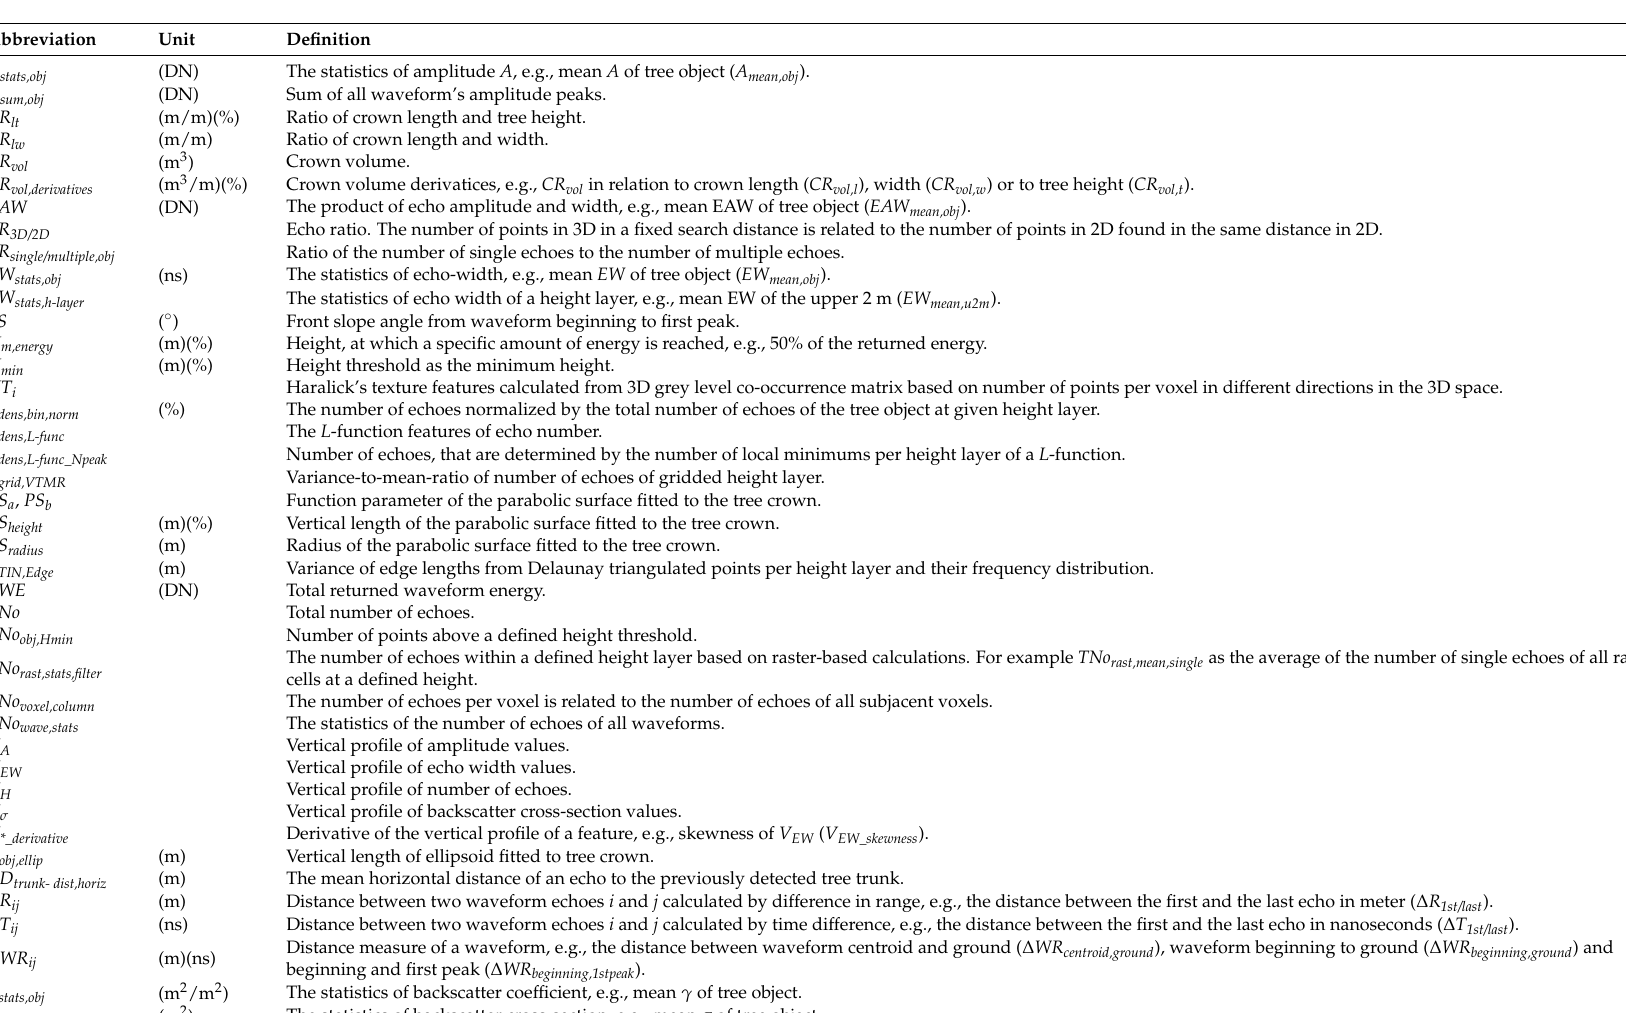
Table A2. The following feature abbreviations are used in this